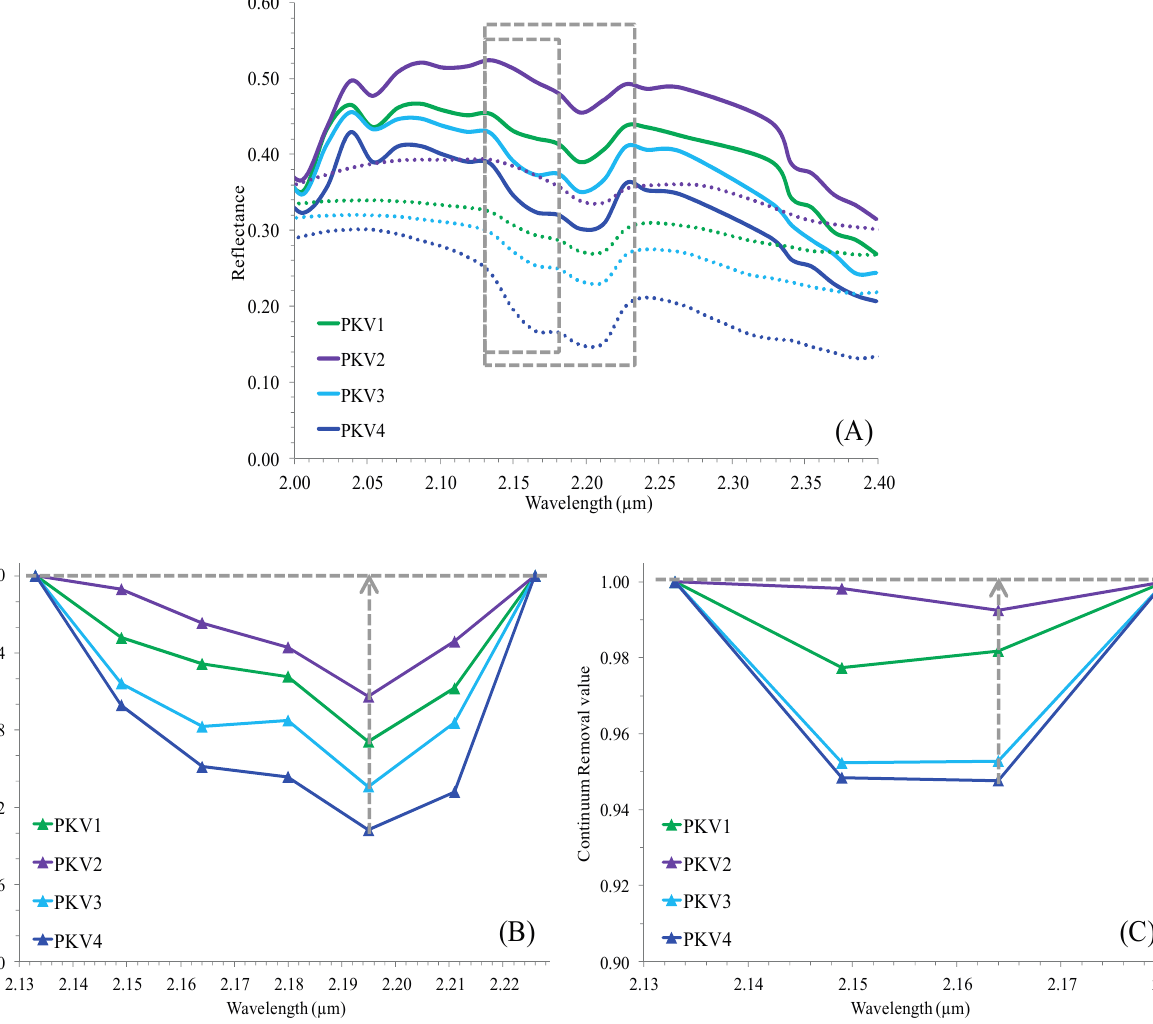
The SWIR reflectance spectra of the land ROIs display a typical absorption feature of 2:1 and 1:1 phyllosilicates with a minimum at 2.196 µm, accompanied by a smaller minimum at 2.165 µm typical to 1:1 kaolinite phyllosilicate. The depth of the absorption at 2.196 µm, as derived from the continuum removal (CR) spectrum between 2.134 and 2.227 µm (henceforth CR ), indicates the amount of 2.196µm 2:1 or 1:1 phyllosilicate in the land. The depth of the absorption at 2.165 µm, as derived from the CR spectrum between 2.134 and 2.181 µm (henceforth CR ), indicates the amount of kaolinite in 2.165µm